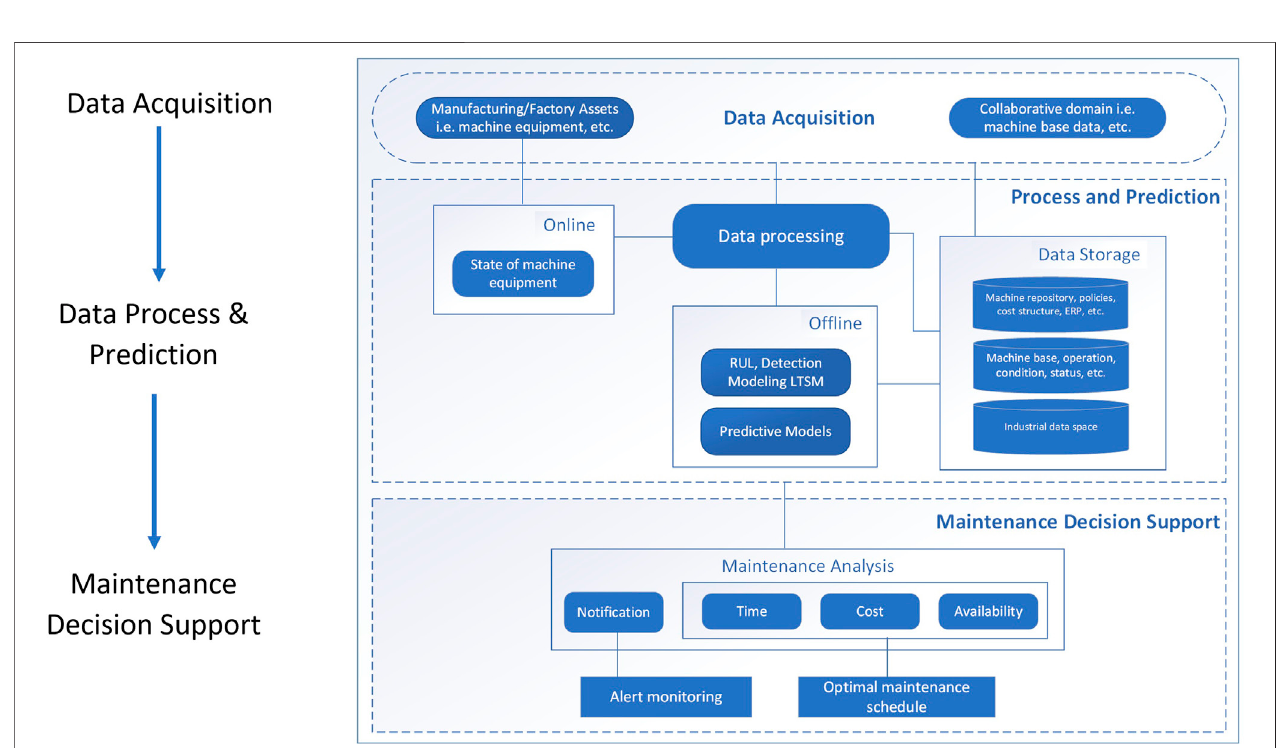
FIGURE 3 | Overall predictive maintenance process and framework.